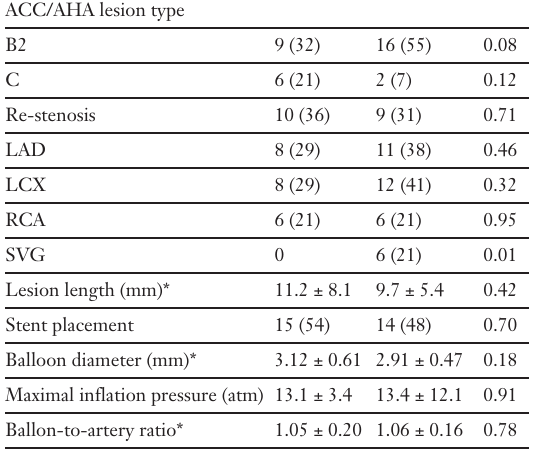
* by Quantitative Coronary Angiography. LAD denotes left anterior descending, LCX denotes left circum-flex, RCA denotes right coronary artery, SVG denotes saphenous vein graft.